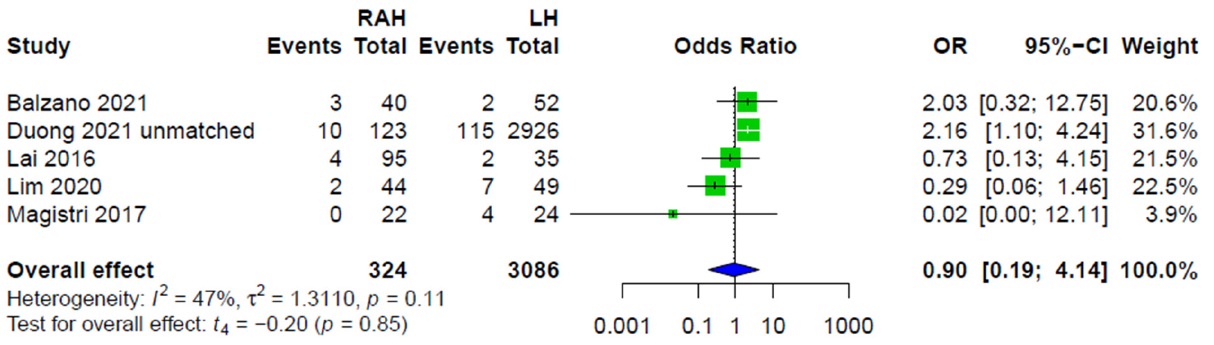
Figure 6. Forest plot for conversion rates during LH and RAH.